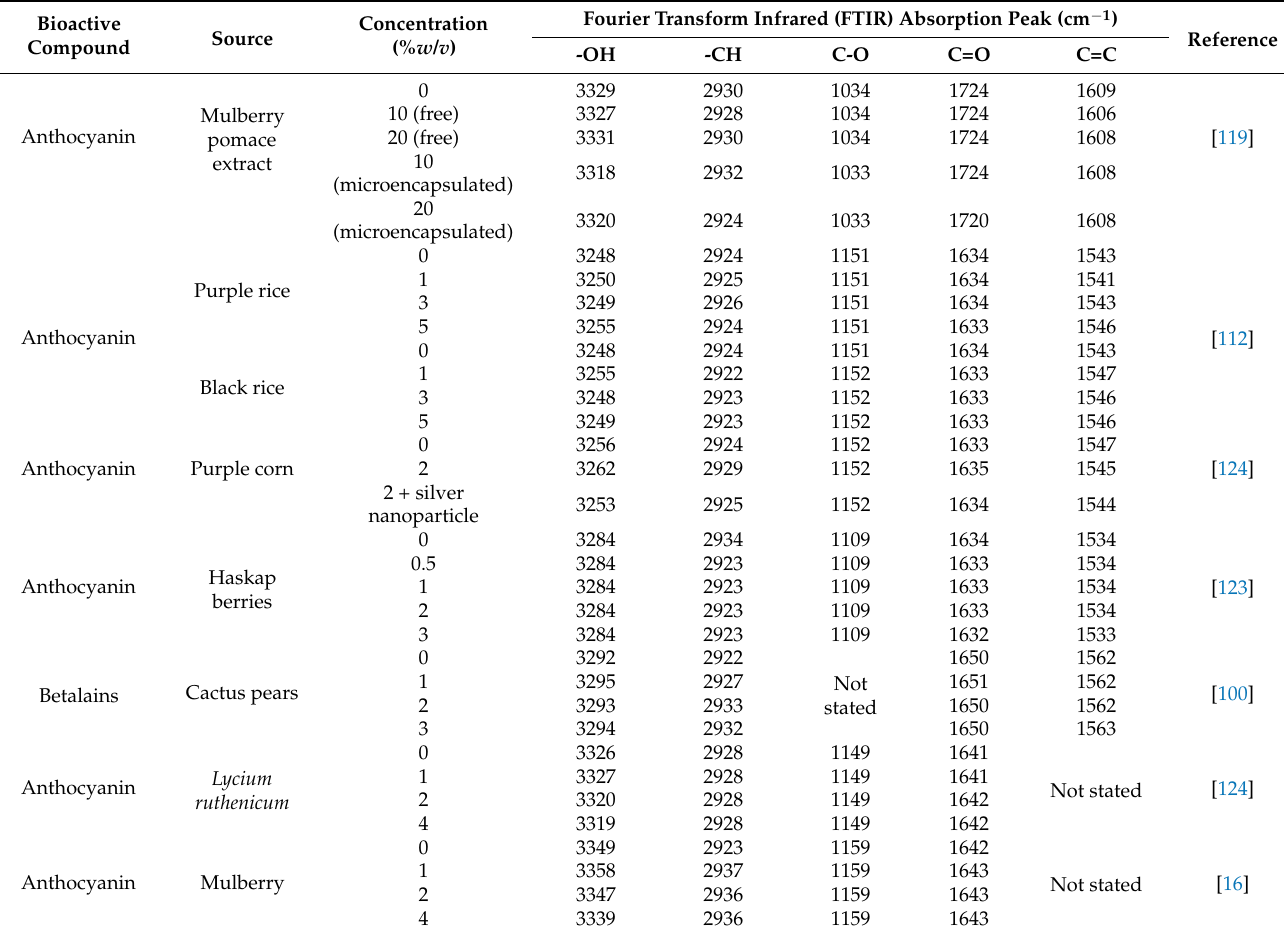
Table 3. Absorption peak of the film packaging as a color indicator at different concentrations of